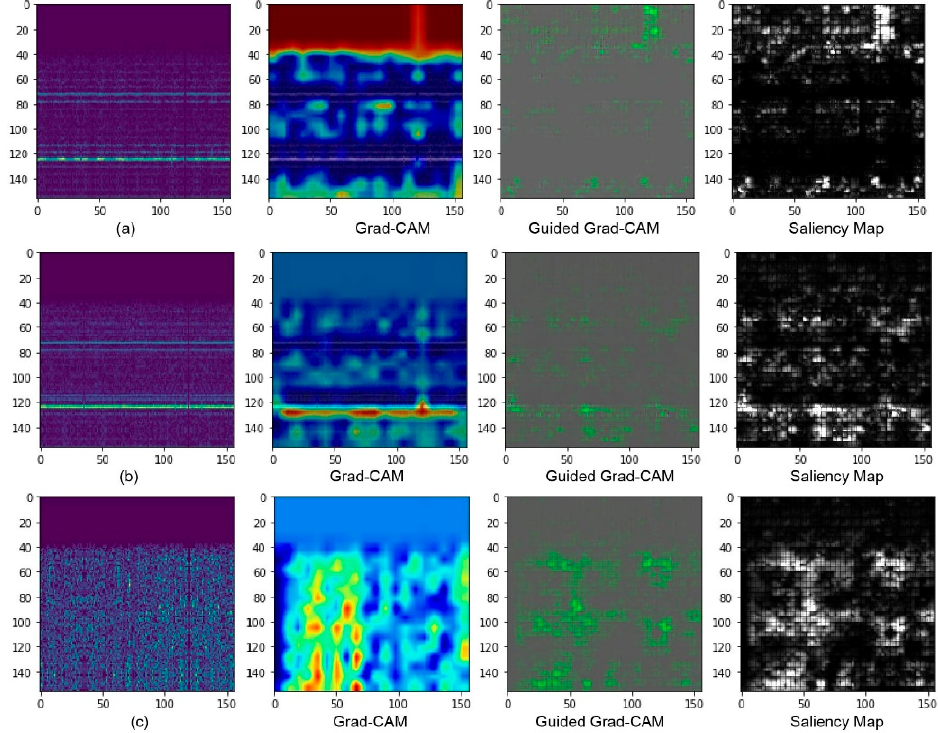
Figure 12. Class activation diagram for lithology recognition.